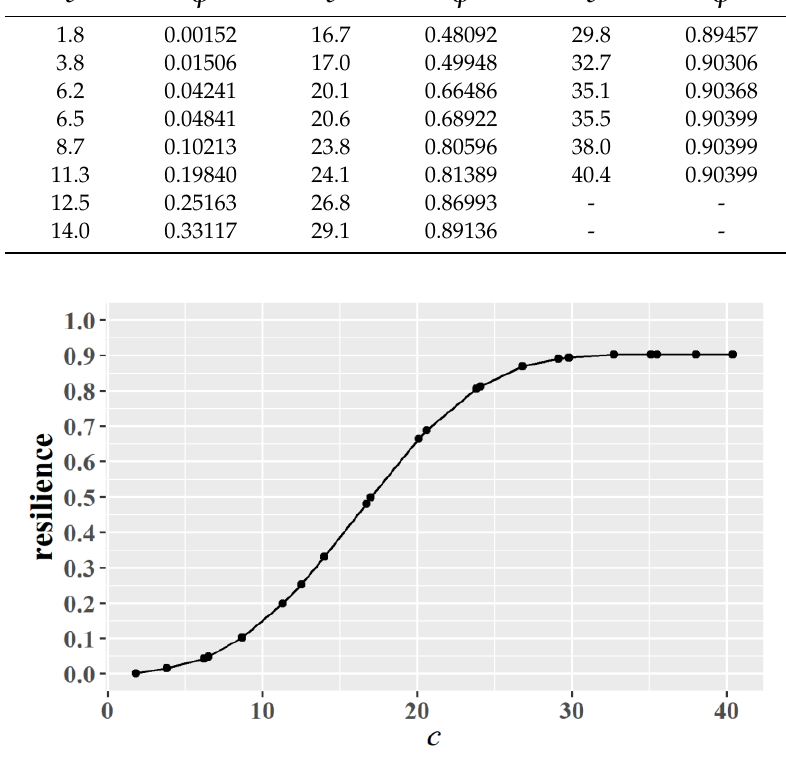
ϕ for di ff erent c from Table Figure 6. 𝜑 for different c from Table 13. Figure 6.